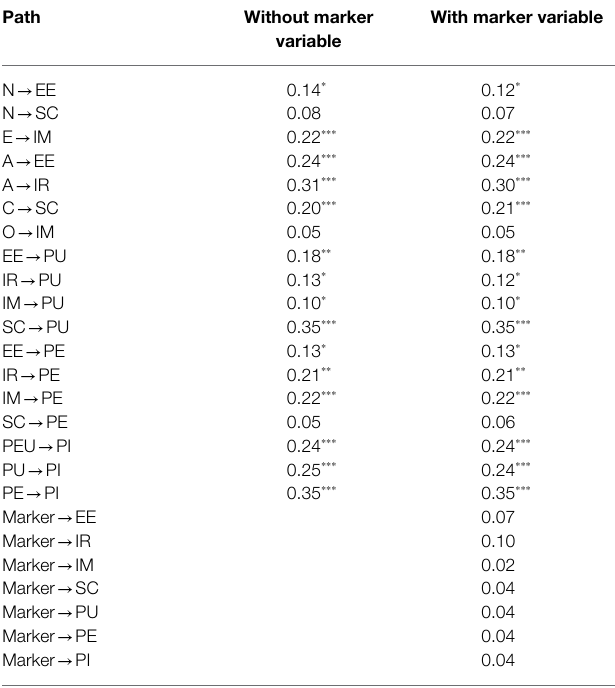
TABLE 6 | The result of common method bias assessment. Path Without marker